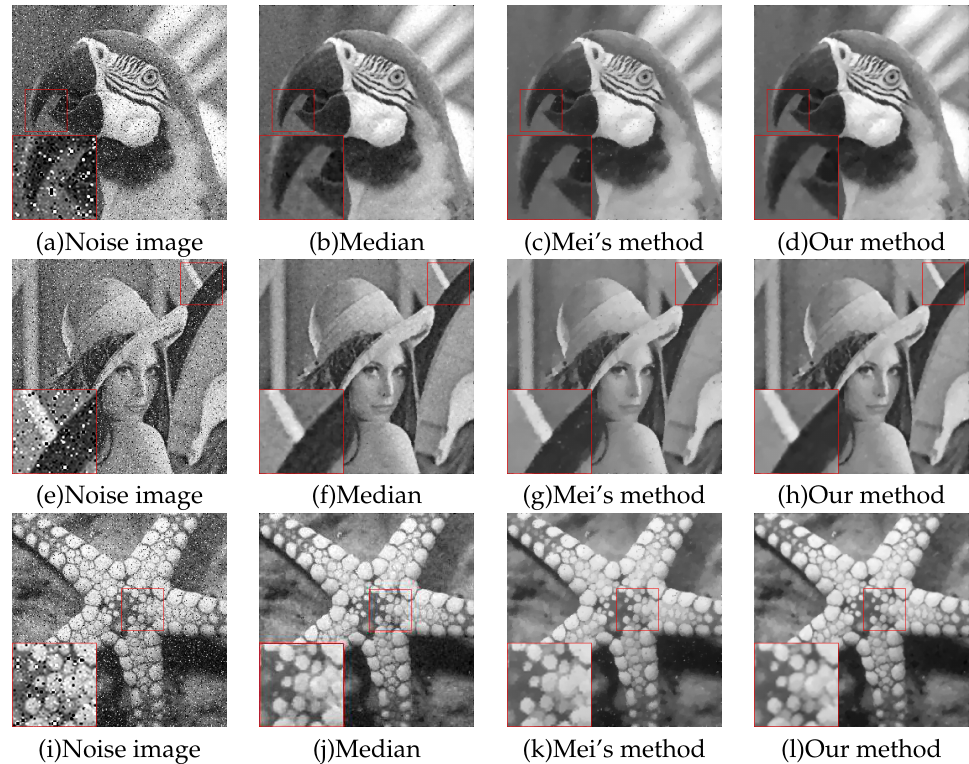
Figure 5. Denoising results of three methods at η = 0.04